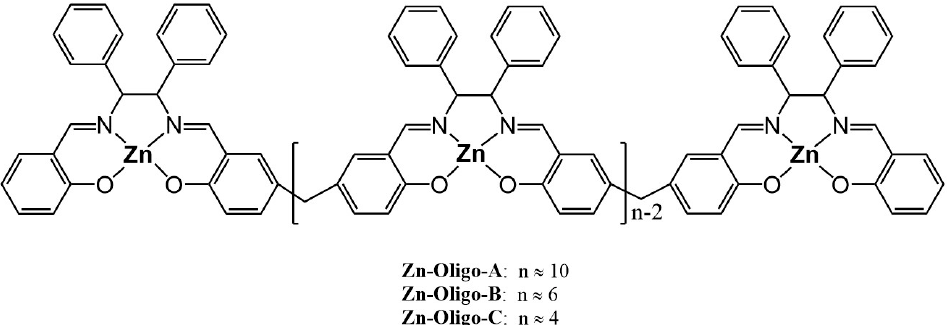
Figure 3. Schematic representation of the Zn–Salen oligomer hosts.